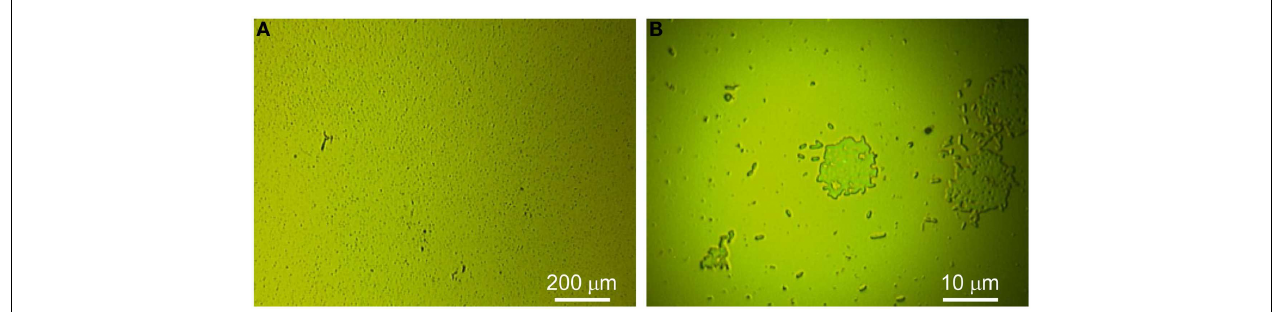
FIGURE 1 | Lag phase biofilm . (A,B) Optical microscopy with 5 × and 100 ×